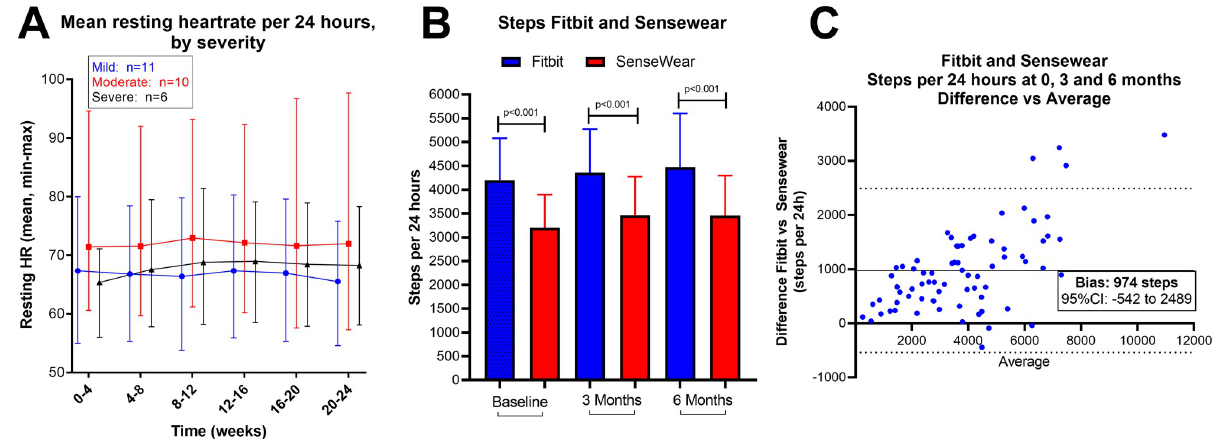
Fig 5. Activity data: Resting heart rate by severity, steps per 24 hours measured with Fitbit and SenseWear. (A) Resting heart rate, mean (min and max) levels, by three severity groups. (B) Steps per 24 hours measured for seven consecutive days by Fitbit and SenseWear, at baseline, 3 months and 6 months. (C) Bland-Altman plot showing difference (bias) between Fitbit and SenseWear devices for measured steps per 24 hours.